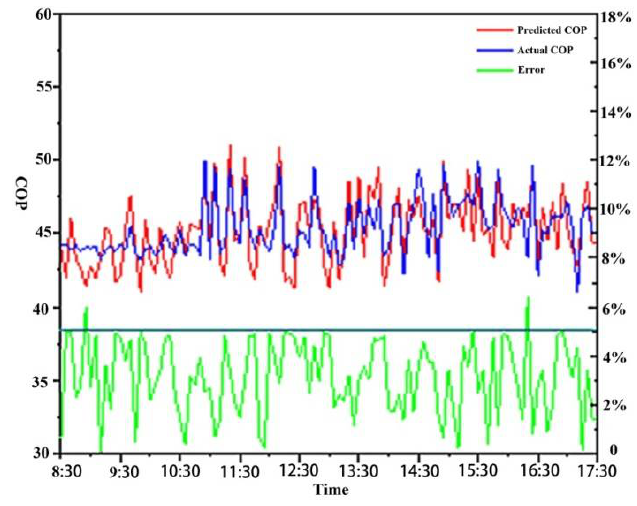
Figure 6. Chiller module prediction COP.